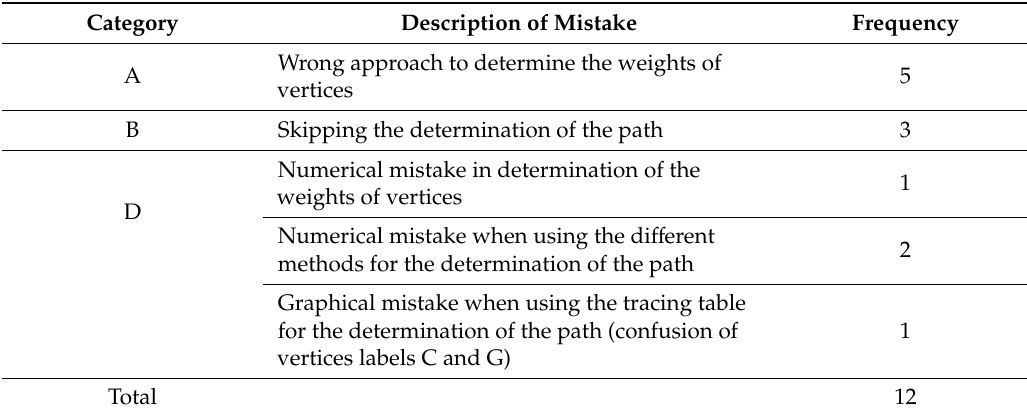
Table 4. Frequenciesofmistakesinstudents’solutionsoftheshortestpathproblem(source: owncalculation). Category Description of Mistake Frequency Wrong approach to determine the weights of A vertices Skipping the determination of the path